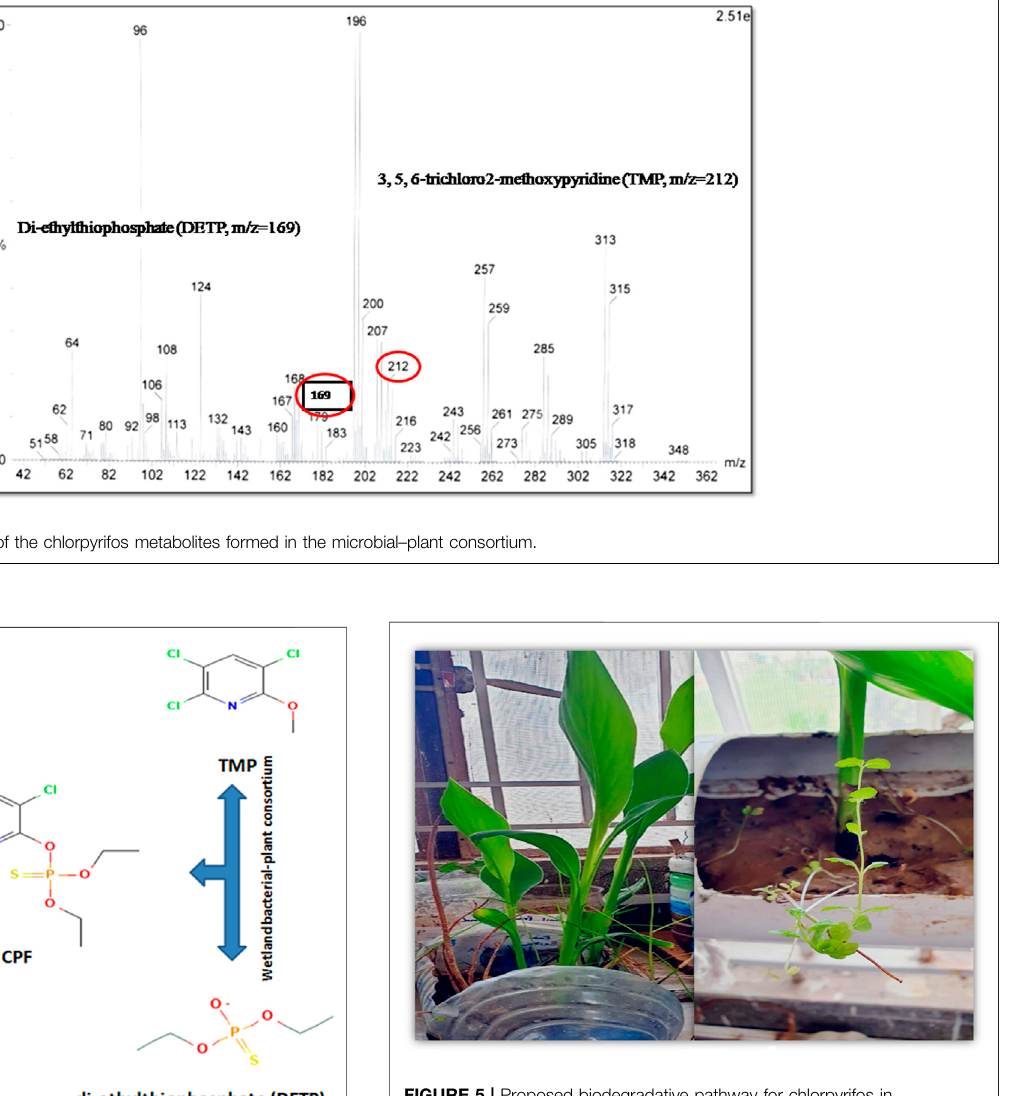
FIGURE 4 | Proto-type constructed wetland with indigenous bacterial strains and Canna and Mentha